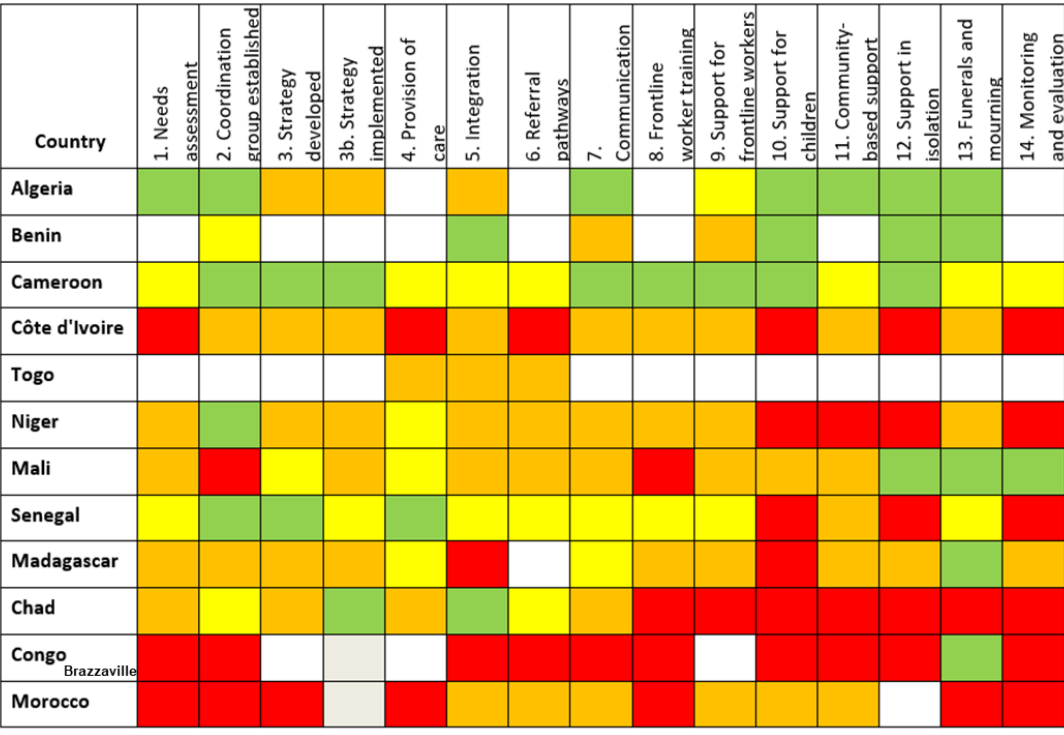
Figure 3. Lusophone countries’ responses to survey based on IASC 14 recommended MHPSS activ- ities in the COVID-19 outbreak. The implementation level in most of the countries (19/28) was below 50% (Figure 4). There were no significant differences in implementation scores by region, income level, or responding institution. However, there were differences between the scores of anglo- phone, francophone, and lusophone respondents, with average scores of 44%, 38% and 22%, respectively. This was not tested for significance due to the small number of luso- phone respondents.